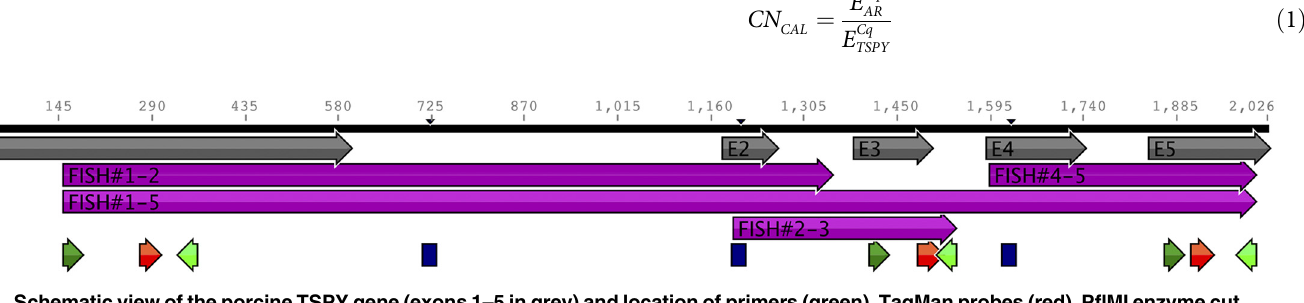
Fig 1. Schematic view of the porcine TSPY gene (exons 1 – 5 in grey) and location of primers (green), TaqMan probes (red), PflMI enzyme cut positions (blue) and FISH probes